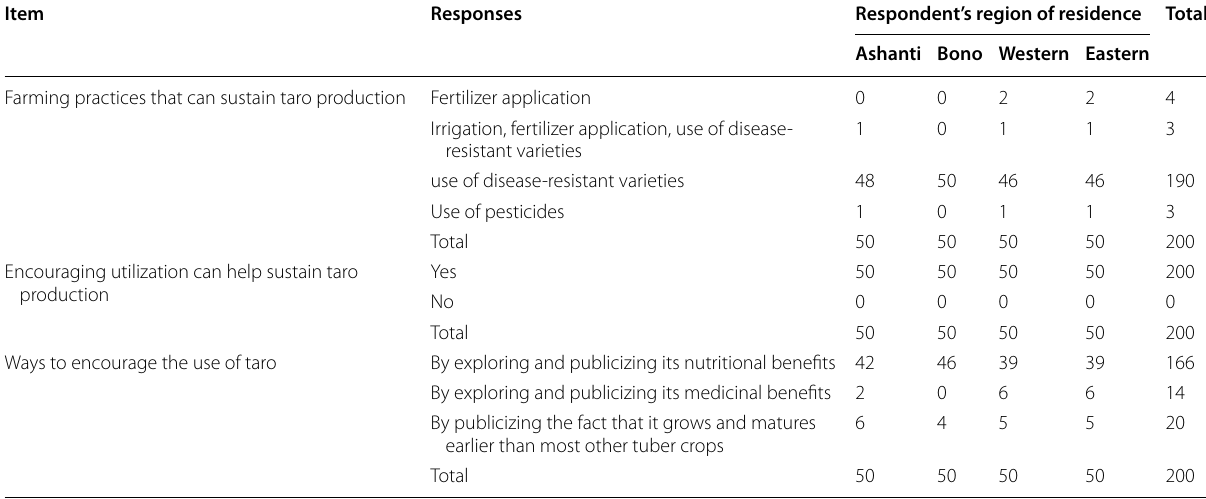
Table 6 Possible remedies to taro extinction Item